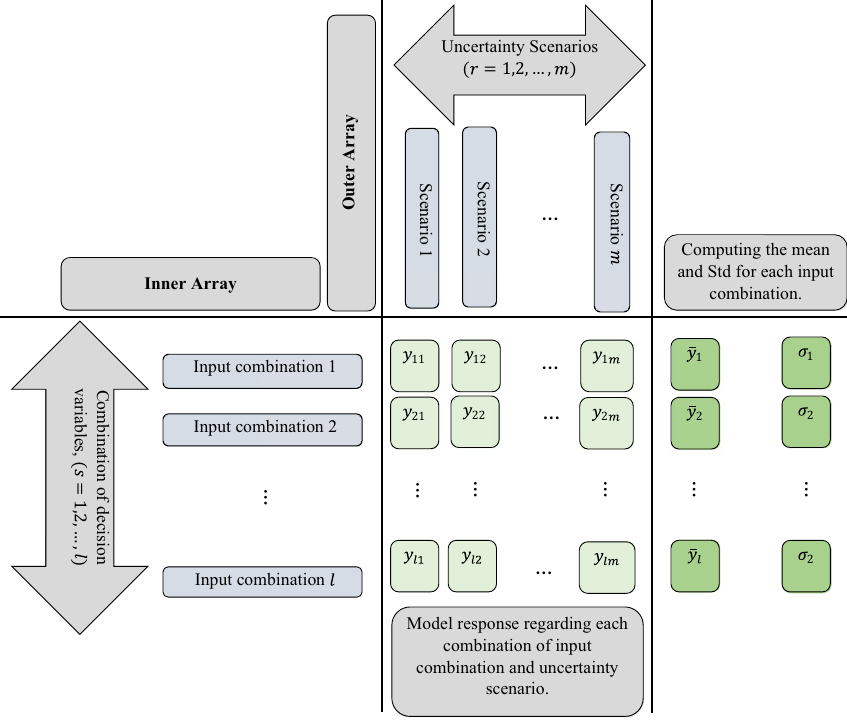
Figure 2. Visualization of crossing the model design parameters and uncertainty scenarios as inspired by the Taguchi’s crossed array